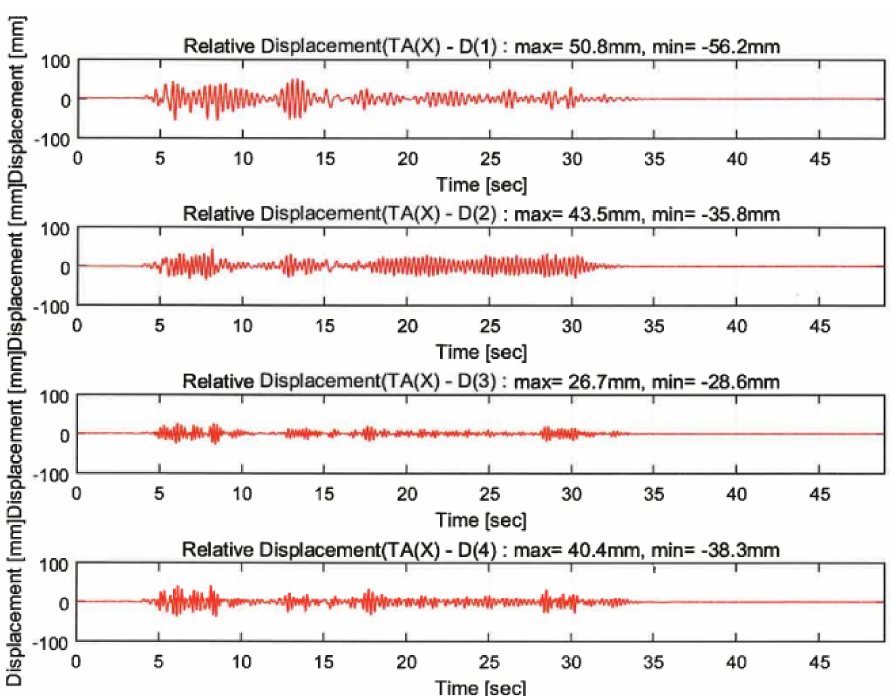
Figure 16. Dynamic responses under 200% El Centro earthquake.